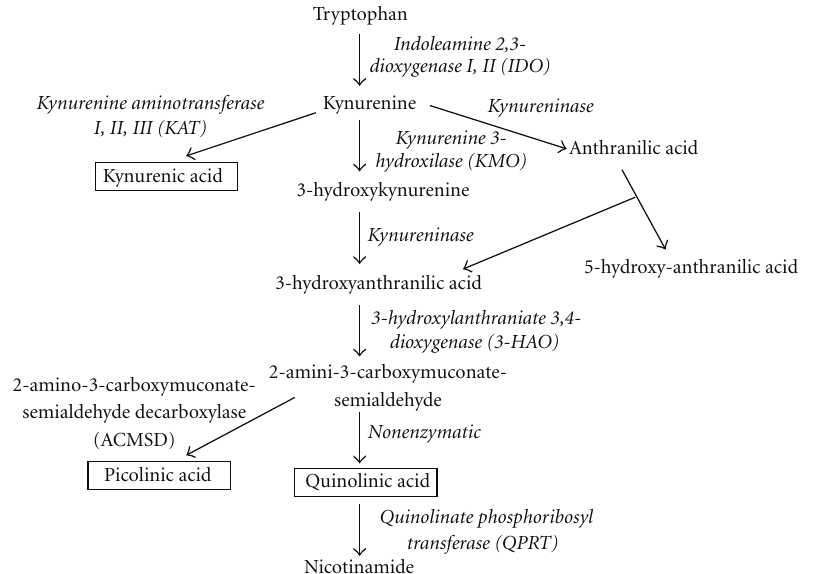
Figure 2: Simplified diagram of Kynurenine pathway: during neuroinflammation, 95% of the dietary tryptophan is metabolized along the KP within the brain. The remaining 5% serves as a precursor to the synthesis of the neurotransmitter serotonin. IDO catalyses the initial and rate-limiting step in the degradation of tryptophan through KP that ultimately leads to the production of